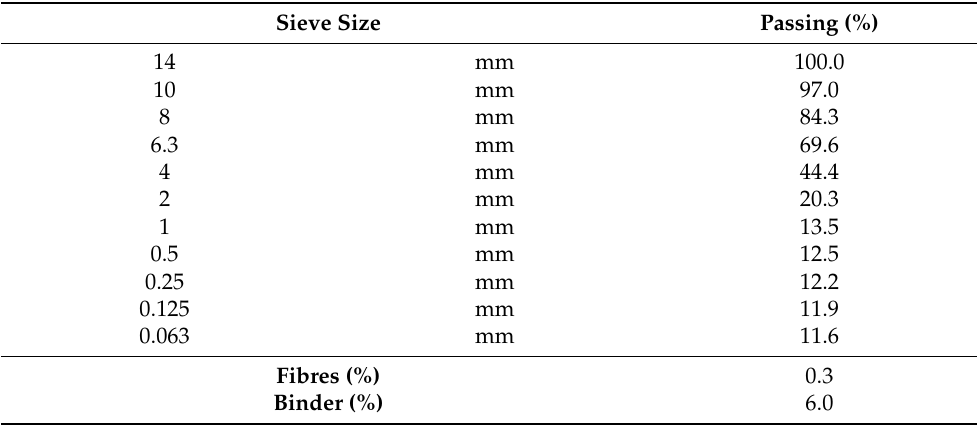
Table 3. Composition of the NTEC laboratory asphalt